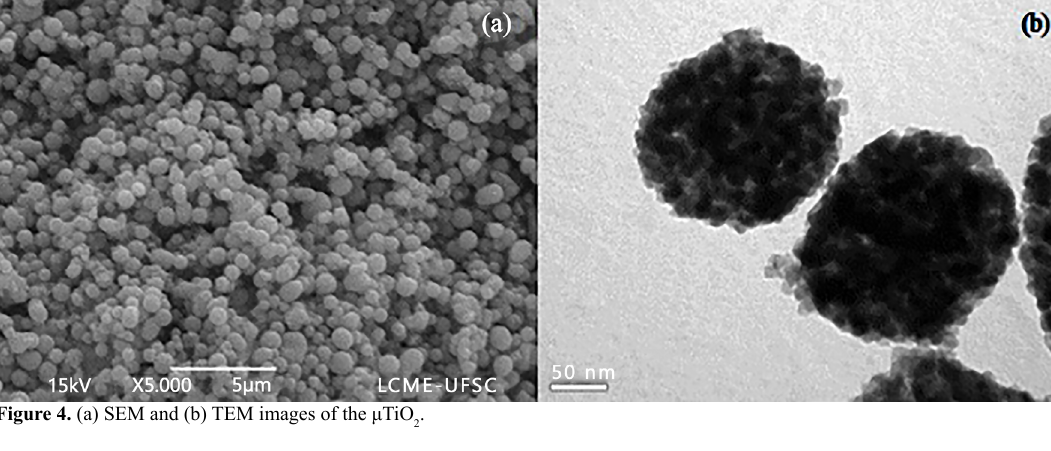
Figure 4. (a) SEM and (b) TEM images of the μTiO